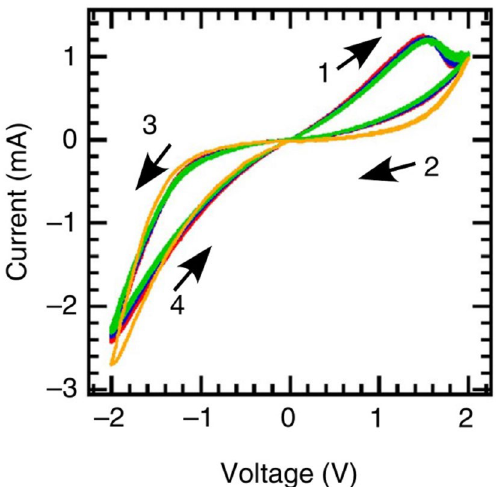
◦ Figure 8. Experimental I–V curve at 25 C of a 90 nm thick substoichiometric amorphous Gallium oxide thin film with a sweeprate of 0.05V s − 1 . The TE has a diameter of 200 µm and the BE a size of 1 cm × 1 cm. Reprinted by permission from Springer Nature Limited: Springer Nature, Nature Communications 6 (Aoki et al). Copyright (2014).